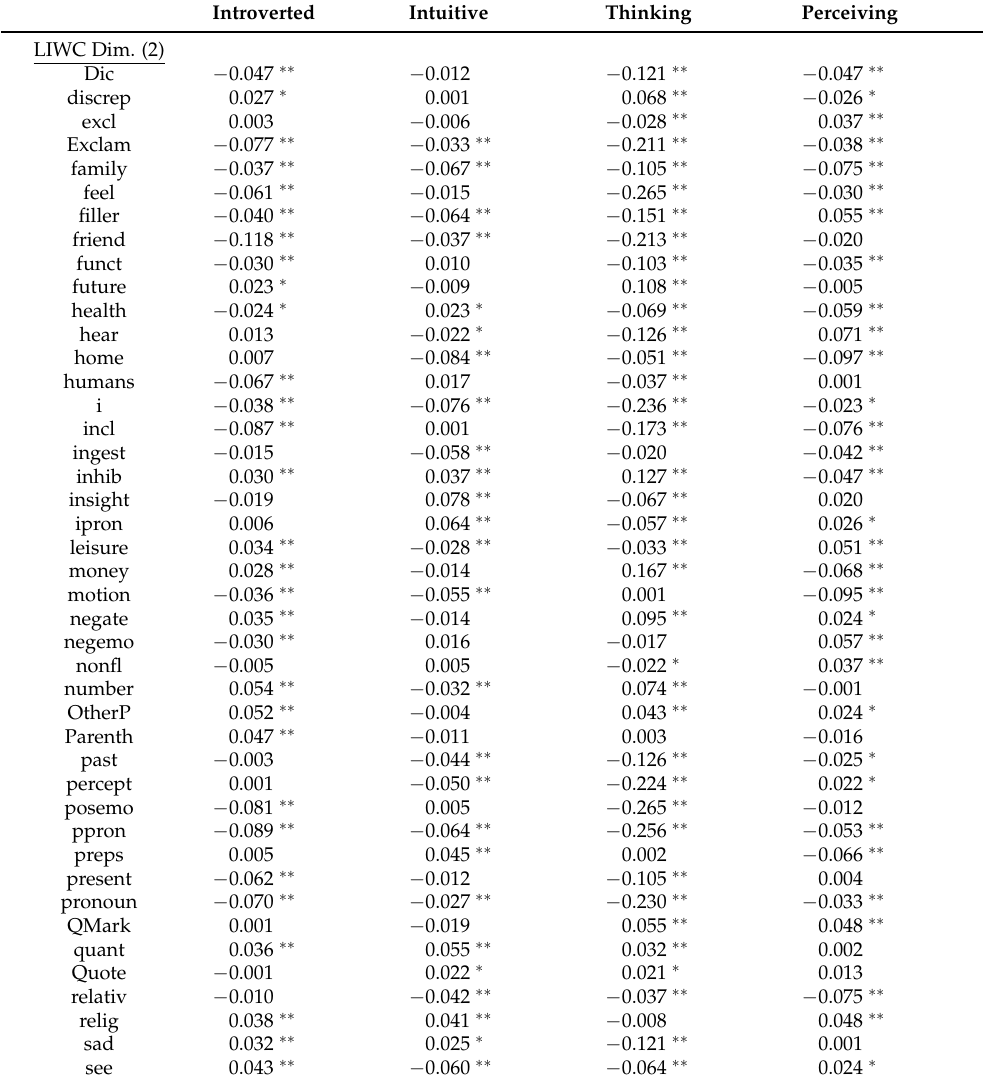
Table 11. Continuation of Table 10—Correlation between MBTI types and LIWC features present in the PANDORA dataset. LIWC features that correlate with at least one MBTI type are shown in the